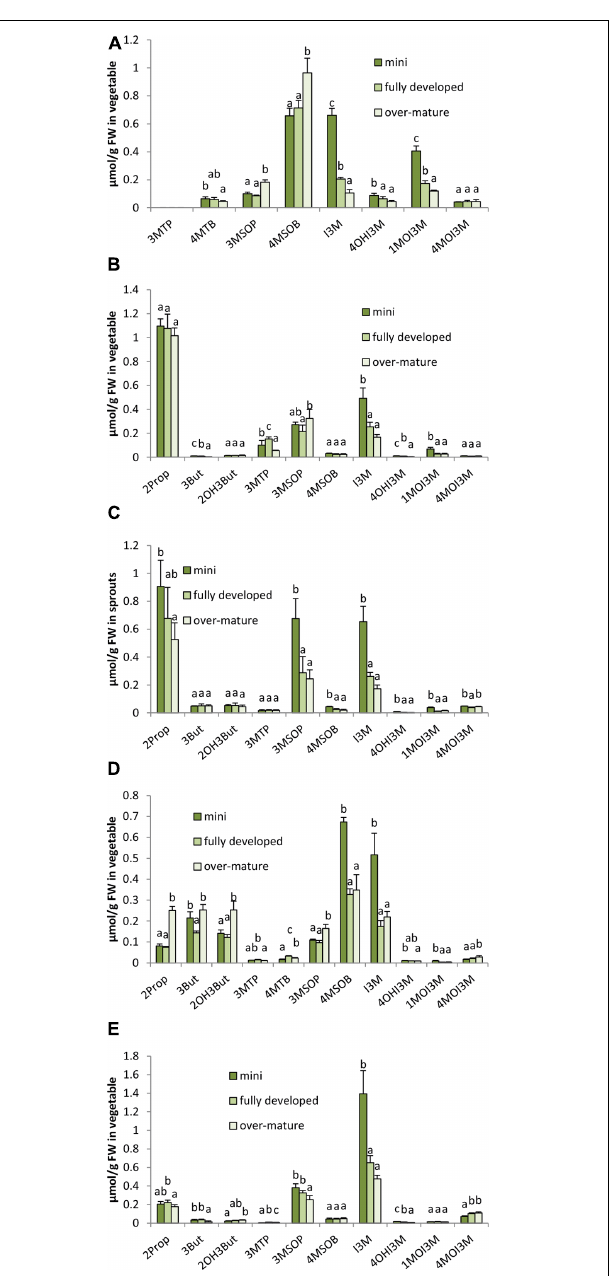
FIGURE 7 | Influence of head ontogeny on the glucosinolate content [ µ mol/g FW] in broccoli (A) , cauliflower (B) , white cabbage (C) , red cabbage (D) , and savoy cabbage (E) . Abbreviations: see Table 2 . Small letters indicate significant differences between means of glucosinolate concentrations of different head developmental stages ( p ≤ 0.05) as determined by Tukey’s HSD test.